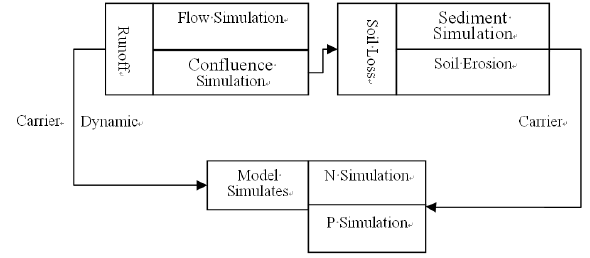
Figure 3. The Process of Simulating with SWAT Model